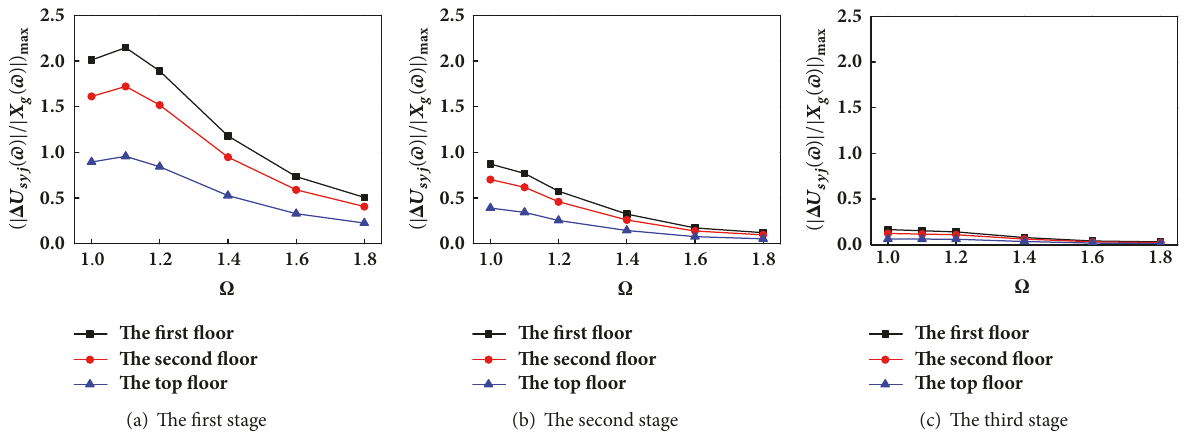
Figure 10: Interstory translation displacement in the 𝑦 direction under different Ω values.